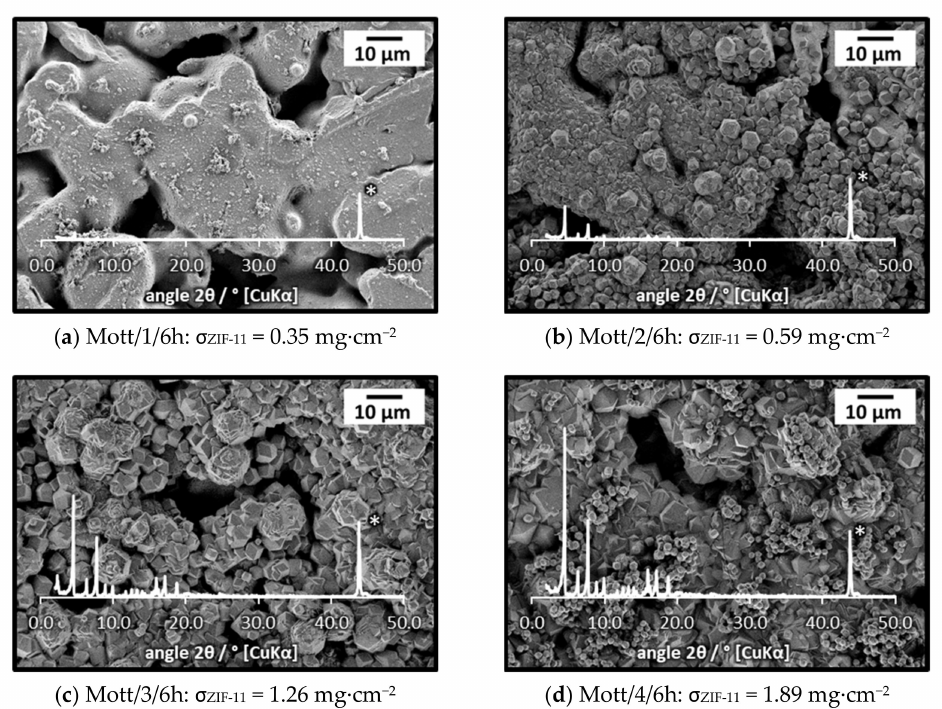
Figure 7. SEM images and XRD patterns of a stainless-steel (Mott) support at different stages of ZIF-11 multiple in situ crystallization in DEF at 60 ◦ C (* support diffraction